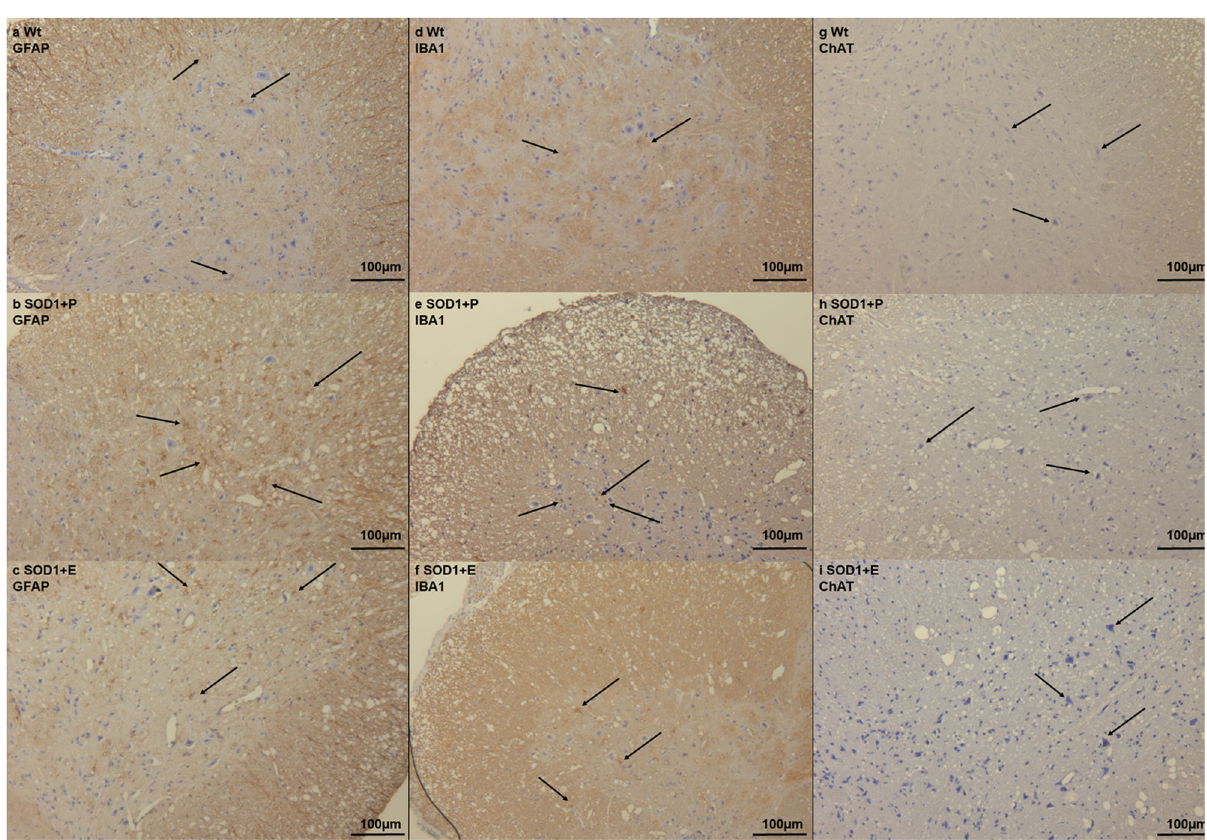
Fig. 4 Immunohistochemical staining in the lumbar spinal from the SOD1 G93A etomoxir experiment. a – c GFAP staining in lumbar spinal cord from Wt, SOD1 + P and SOD1 + E mice at day 130 indicating increased number of reactive astrocytes in the ventral horn in SOD1 + P mice (arrows) compared to Wt and SOD1 + E mice. d – f IBA1 staining in lumbar spinal cord from Wt, SOD1 + P and SOD1 + E mice at day 130, indicating increased labeling and in fi ltration of reactive microglia in the ventral horn in SOD1 + P mice (arrows) compared to SOD1 + E and Wt mice. g – i ChAT staining in lumbar spinal cord from Wt, SOD1 + P and SOD1 + E mice at day 130 indicating decreased labeling in SOD1 + P mice (arrows) and pathological morphology of neurons. All images are presented with x16 magni fi cation. N = 2 – 4 animals per group. WT = wild-type, SOD1 = SOD1 G93A genotype, E = etomoxir, P =